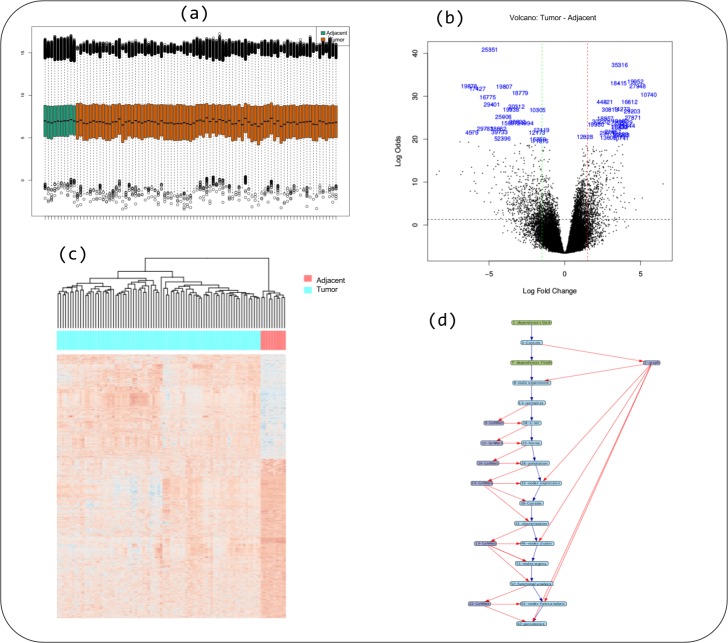
Some captions of figures generated during workflow execution: (A) boxplot of quality indicator, (B) volcano plot, (C) heatmap of genes differentially expressed in tumor versus adjacent, and (D) the provenance trace of a GeNNet-Wf execution is represented as a data derivation graph (DDG).